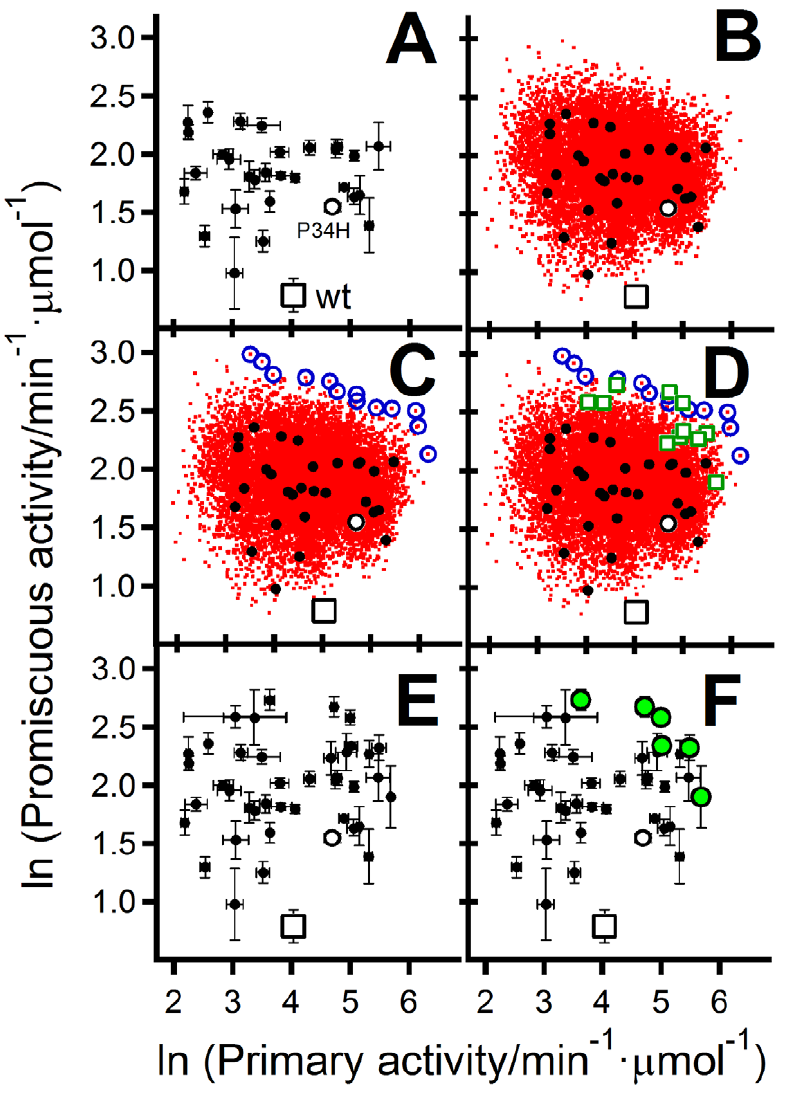
Figure 5. Approximation to the Pareto set of optimum primary/promiscuous activities. (A) Values of the primary and promiscuous activities for 29 variants randomly selected from a combinatorial library based on the 10 mutations derived from SCA analysis (see text and Figure 4). Values for the wild-type thioredoxin from E. coli and the background P34H variant are also included. Note that logarithms of activities are used here in and also in all the other panels of this figure. (B) Partial-least-squares (PLS) reconstruction of the data for the whole combinatorial library (small red data points). The experimental data of panel A (used as a basis for the reconstruction) are also shown, although, for the sake clarity we have omitted the errors bars here (as well as in panels C and D). The reconstructed data (red points) are actually derived from 20 bootstrapping replicas (see Methods for details). (C) Prediction of the Pareto set from the PLS-reconstructed data. The 11 variants belonging to this predicted Pareto set are shown with blue circles. (D) The actual experimental activity values for the 11 variants are shown (open green squares). (E) Expanded experimental variant set including the original 29 variants (panel A), the wild-type thioredoxin from E. coli , the P34H background variant and the 11 variants added as a result of PLS-reconstruction/Pareto-set-prediction (panels C and D). (F) The actual Pareto set of the expanded variant set is shown (green data points).